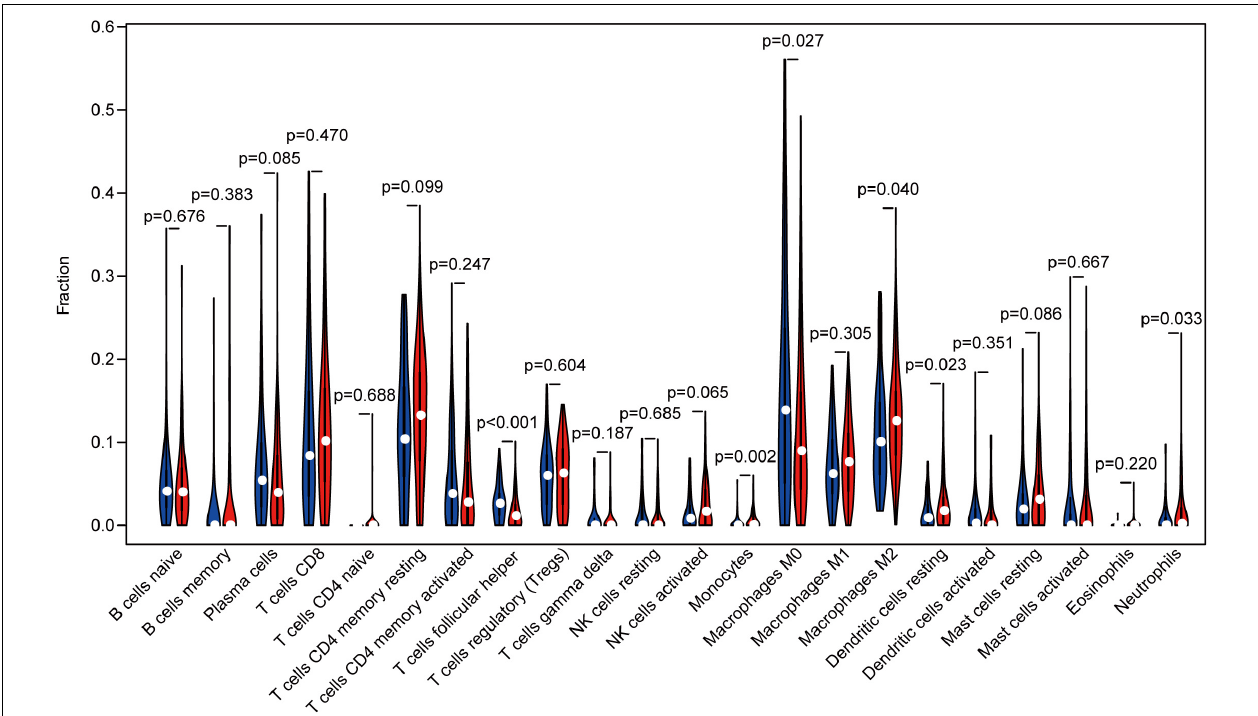
FIGURE 3 | The proportion of 22 subpopulations of immune cells [T cells follicular helper, monocytes, M0 macrophages, M2 macrophages, resting dendritic cells, and neutrophils are main immune cells affected by NNMT expression. Among them, monocytes ( p = 0.002), M2 macrophages ( p = 0.040), resting dendritic cells ( p = 0.023), and neutrophils ( p = 0.033) are apparently increased in high expression group compared with low expression group. In contrast, T cells follicular helper ( p < 0.001) and M0 macrophages ( p = 0.027) are decreased in high expression group compared with low expression